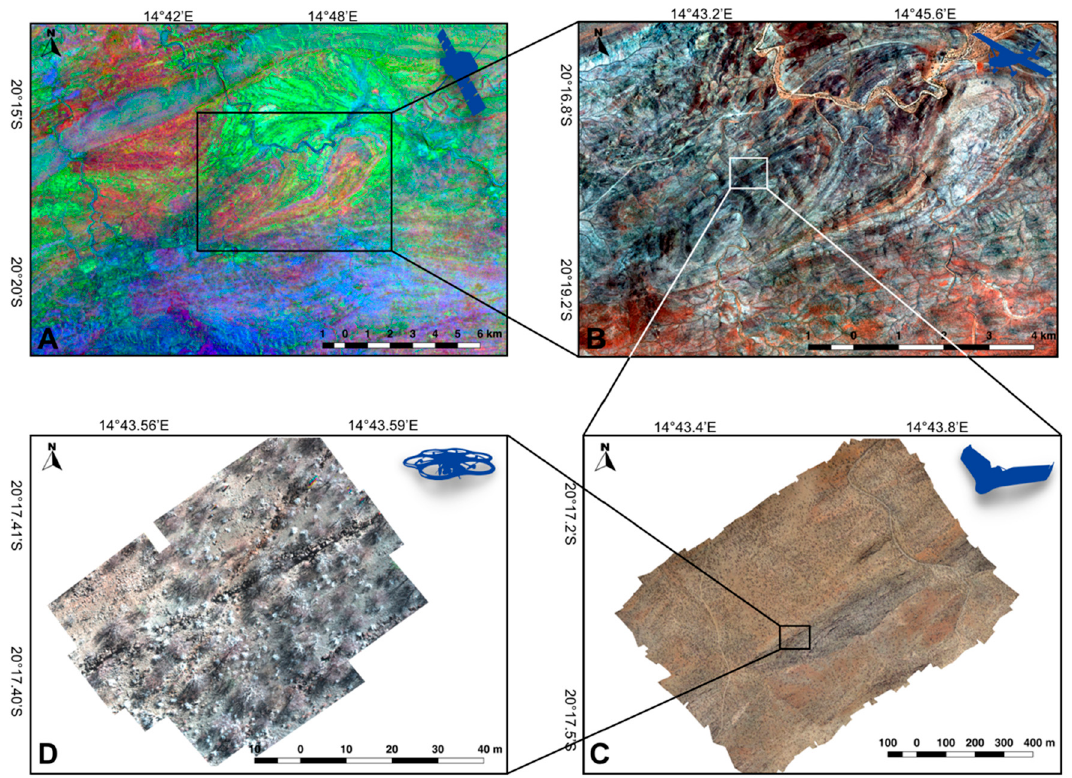
Figure 7. Diagram showing the various platforms used for multi- and hyperspectral imaging and the areas focused on with each platform. ( A ) False color composite of ASTER data showing lithological discrimination of the Lofdal area (B4 / B7 - B4 / B3 - B2 / B1). ( B ) Near-infrared (NIR), green, and blue HyMap image of Lofdal. ( C ) Orthophoto of Lofdal. ( D ) High-resolution RGB image from the Rikola showing individual dykes.